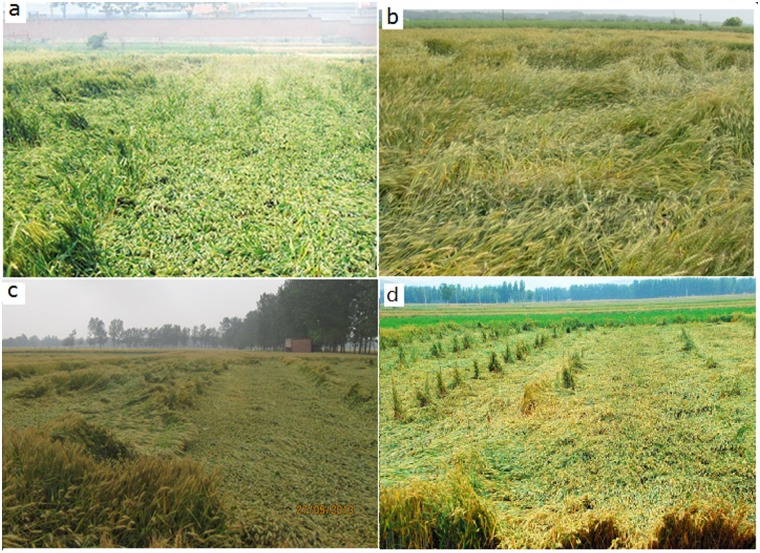
Lodging due to continuous rainfall.a. Jining city, Shandong (05/22/2007). b. Langxi county, Anhui (05/08/2012). c. Xinxiang city, Henan (05/26/2013). d. Zaozhuang city, Shandong (05/26/2013).